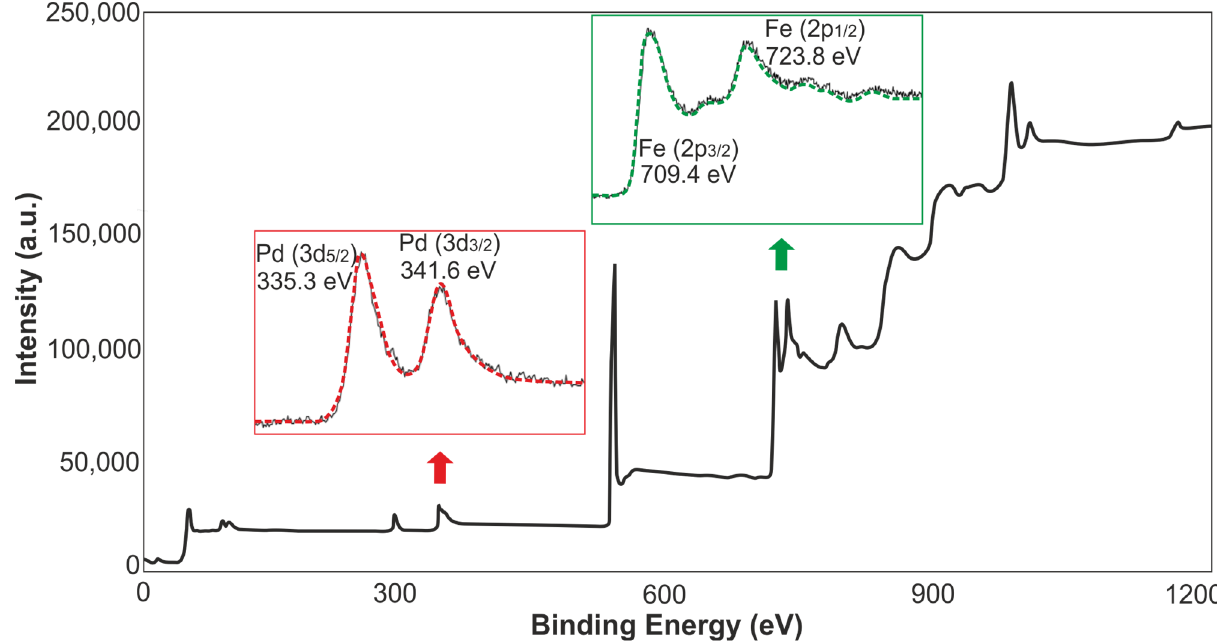
Figure 6. XPS analysis of Pd-Fe 3 O 4 -CWH nanocatalyst. Figure 5. XPS analysis of Pd-Fe 3 O 4 -CWH